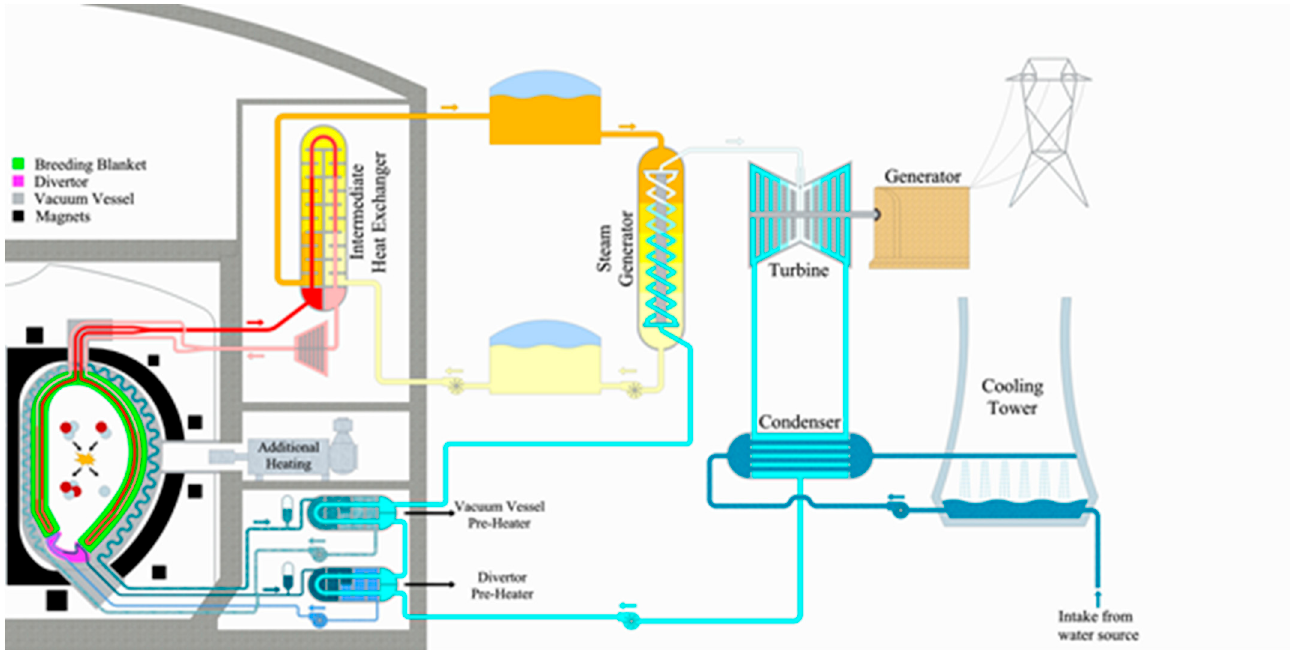
Figure 2. Conceptual scheme of the helium-cooled pebble bed Balance of Plant with an energy storage system. Reprinted with permission from [7]. Copyright 2019 Elsevier.